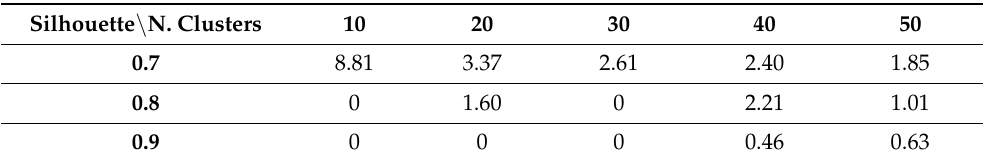
Table 6. Clustering performance in terms of silhouettes using the reduced dataset with SPQR applied to normalized data. Silhouette \ N.